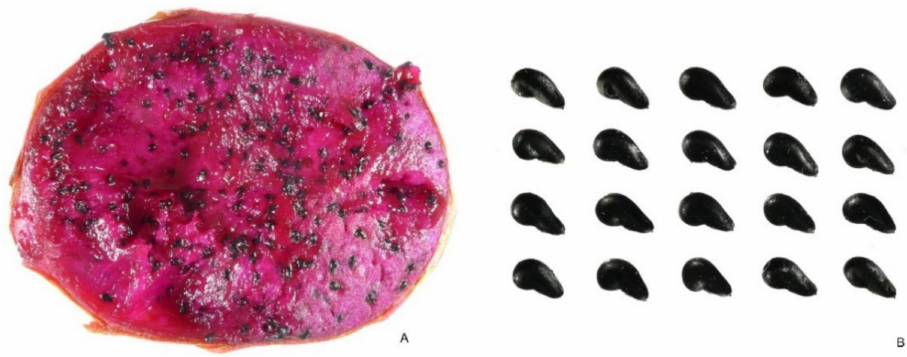
Figure 5. Hylocereus undatus . ( A ) Section of a fruit. ( B ) Seeds. Bar equals 1 cm.